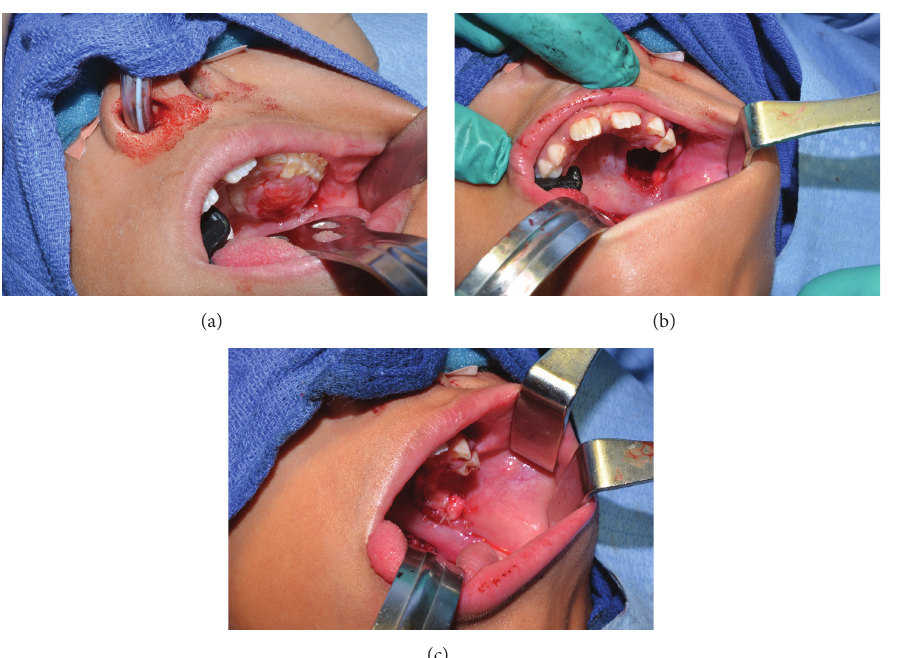
Figure 1: Physical examination showing an ulcerated mass on the left hard palate (a), the status of the palatal defect after resection (b), and the reconstructing using mucosal advancement flap (c).